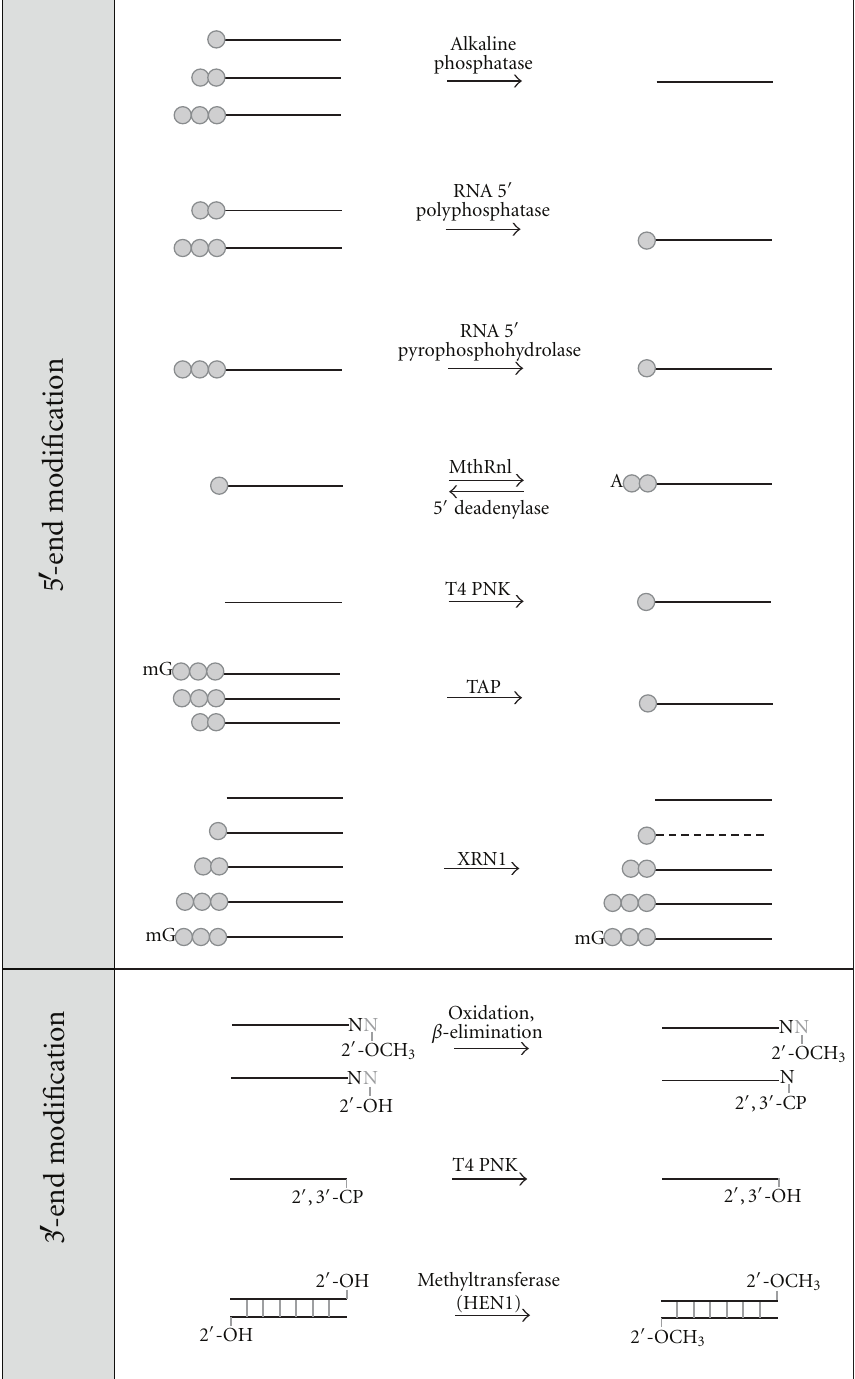
Figure 1: Enzymatic manipulation of RNAs with modifications at their 5 (cid:3) - or 3 (cid:3) -ends. Black lines represent RNA with the left and right ends representing the 5 (cid:3) - and 3 (cid:3) -ends, respectively. One, two, or three grey circles represent mono-, di-, or triphosphate at the 5 (cid:3) -end. “A” and “mG” represent a 3 (cid:3) to 5 (cid:3) AMP and cap structure at RNA 5 (cid:3) -end. “2 (cid:3) -OH” or “2 (cid:3) , 3 (cid:3) -OH” represents RNAs with no modification at the 3 (cid:3) -end. “2 (cid:3) -OCH 3 ” and “2 (cid:3) , 3 (cid:3) -CP” represent 2 (cid:3) -O-methylation and 2 (cid:3) , 3 (cid:3) -cyclic phosphate at the 3 (cid:3) -end, respectively. Dashed lines represent degraded RNA. The nucleotide “N” in grey color represents the nucleotide removed during the β -elimination reaction. MthRnl, TAP, T4 PNK, and XRN1 are the abbreviations of Methanobacterium thermoautotrophicum RNA ligase, tobacco acid pyrophosphatase, T4 polynucleotide kinase, and a 5 (cid:3) -monophosphate-dependent 5 (cid:3) to 3 (cid:3) exoribonuclease,